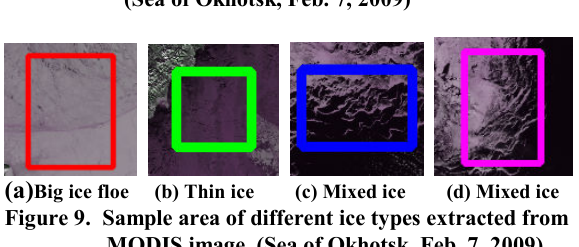
Figure 8. Comparison of MODIS and AMSR-E images.